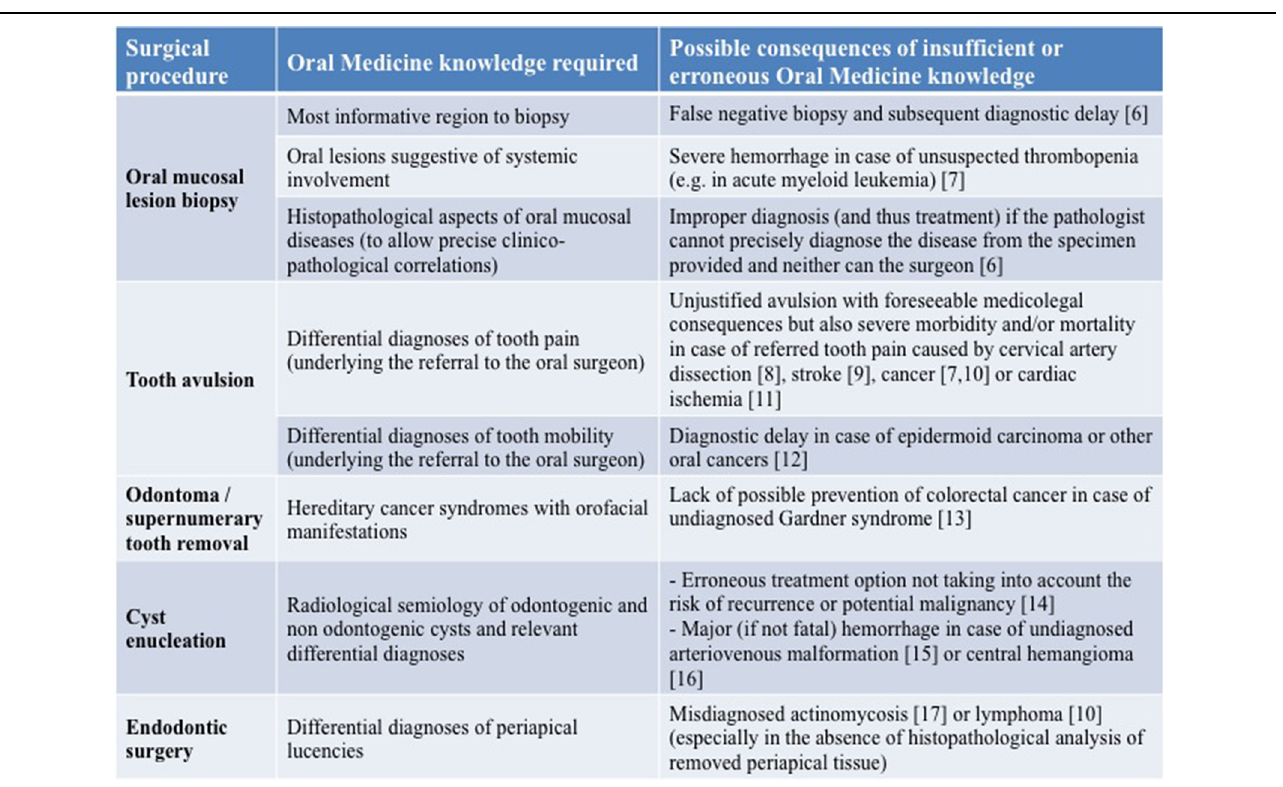
Table I. Non exhaustive examples of the complementarity between oral surgical procedures and necessary Oral Medicine knowledge with resulting possible consequences in cases of insuf fi cient or erroneous